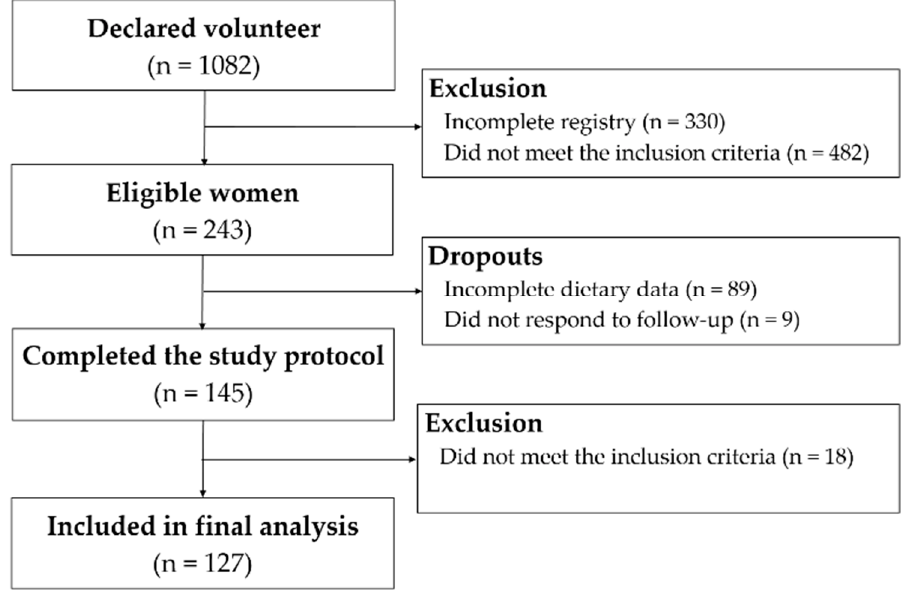
Figure 1. Study flow diagram.